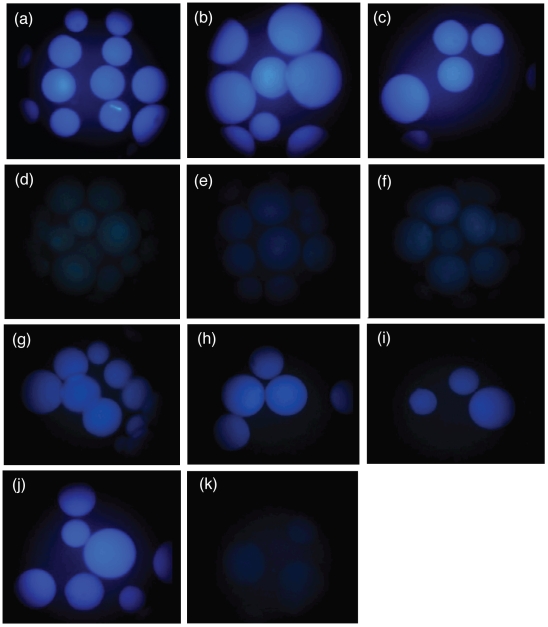
Fluorescence microscope images of the peptides shown in figure 8.The images were taken at the excitation wavelength range of 360/40 nm and emission wavelength range of 420/40 nm. Peptides not assayed with the POP enzyme: (a) NH2FGK(Abz)A-PEGA1900 (b) NH2FGK(Abz)O2Oc-PEGA1900 (c) NH2FGK(Abz)(O2Oc)2-PEGA1900 (d) NH2F(p-NO2)GFGPFGK(Abz)A-PEGA1900 (e) NH2F(p-NO2)GFGPFGK(Abz)O2Oc-PEGA1900 (f) NH2F(p-NO2)GFGPFGK(Abz)(O2Oc)2-PEGA1900. Images of the peptides (d) to (f) after the assay with the POP enzyme are shown in Figures (g) to (i). Fluorescence controls are (j) NH2-Abz-PEGA1900 (positive control) and (k) PEGA1900 (negative control).